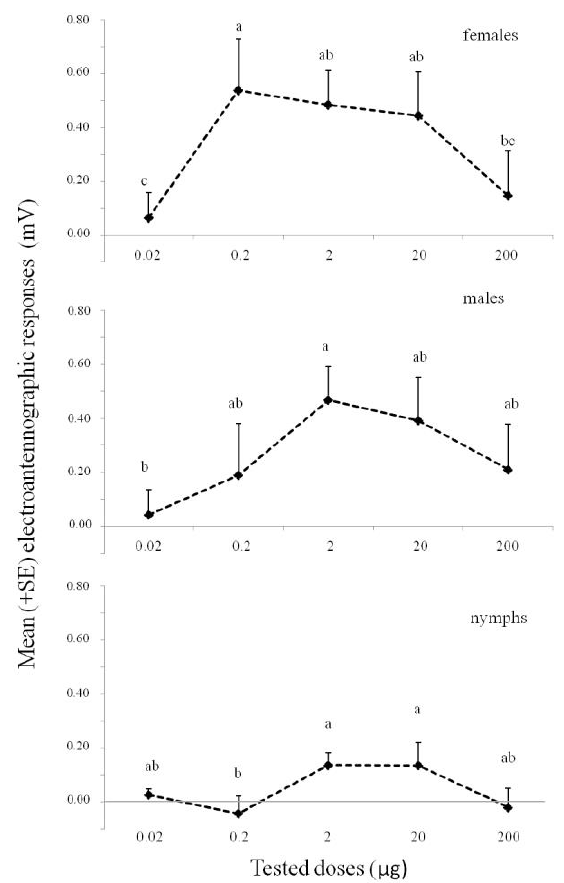
Figure 1. EAG dose – response curves of Bagrada hilaris individuals (female n = 7; male n = 7; nymphs n = 6) to ( E )-2-octenyl acetate at different doses. EAG amplitudes were adjusted to a control stimulus (acetone). Different letters indicate that values differ statistically at p < 0.05 (ANOVA, followed by LSD test).